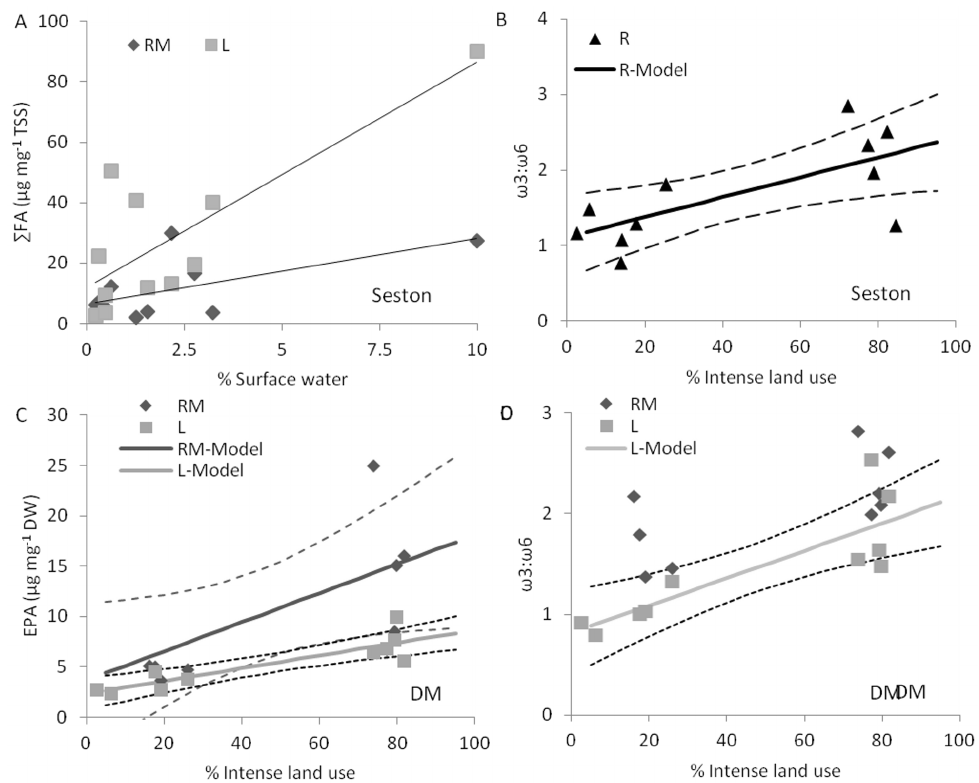
Figure 6. Relationships between selected FA properties and land cover characteristics. A) The percent of the watershed that is open water versus the total fatty acids ( g FA) in seston. Solid and dashed lines show the model at rivermouth (RM) and nearshore lake (L) sites, respectively. This relationship is driven by a single outlier, casting doubt on its usefulness, so no credible interval has been estimated. The proportion of the watershed that is intense land use and the B) seston v 3: v 6 at river (R) sites, C) dreissenid mussel (DM) EPA at rivermouth (RM) and nearshore zone (L) sites and D) DM v 3: v 6 in L sites. For statistically significant relationships in B-D, the solid lines show the model and dashed lines of the same color indicate 95% credible intervals of the estimated model.